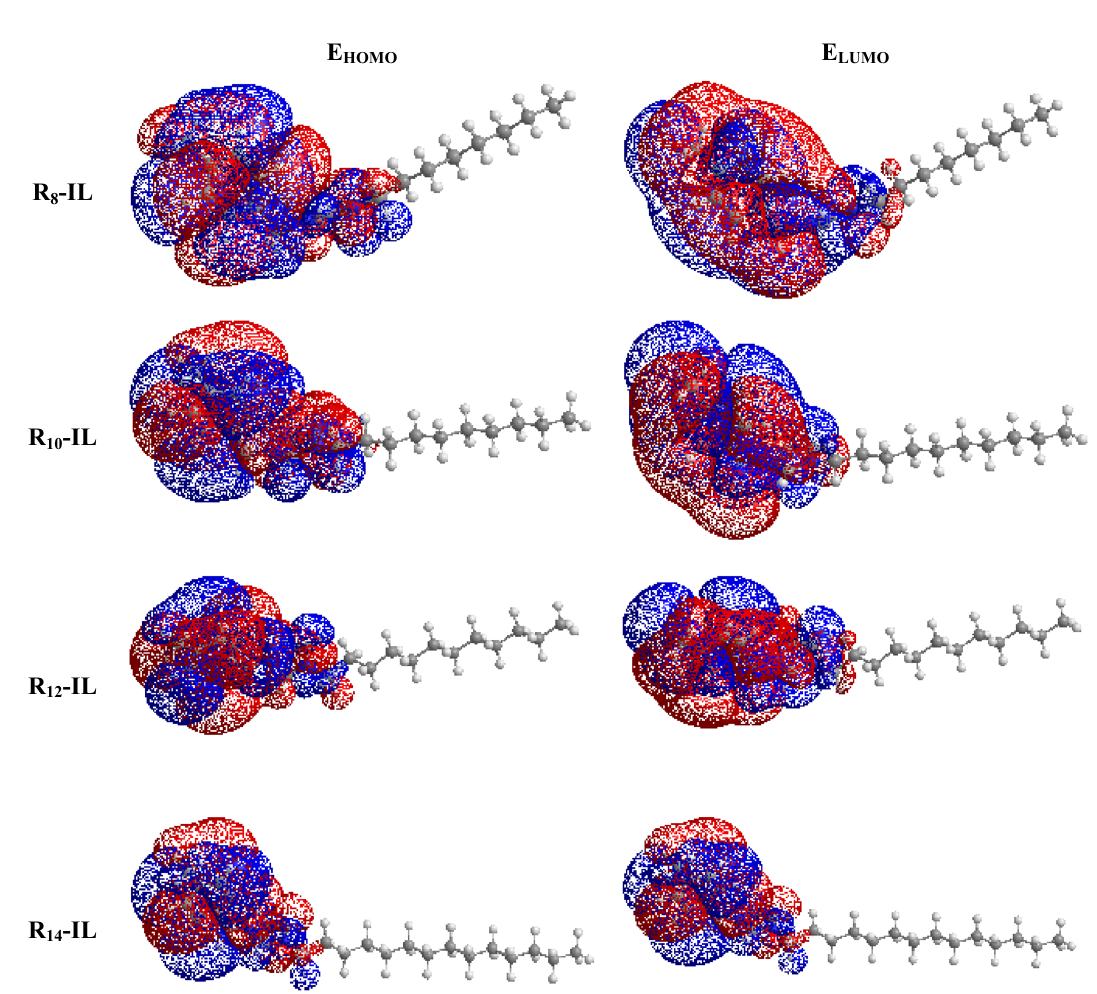
Figure 4. Molecular orbital structures of the prepared